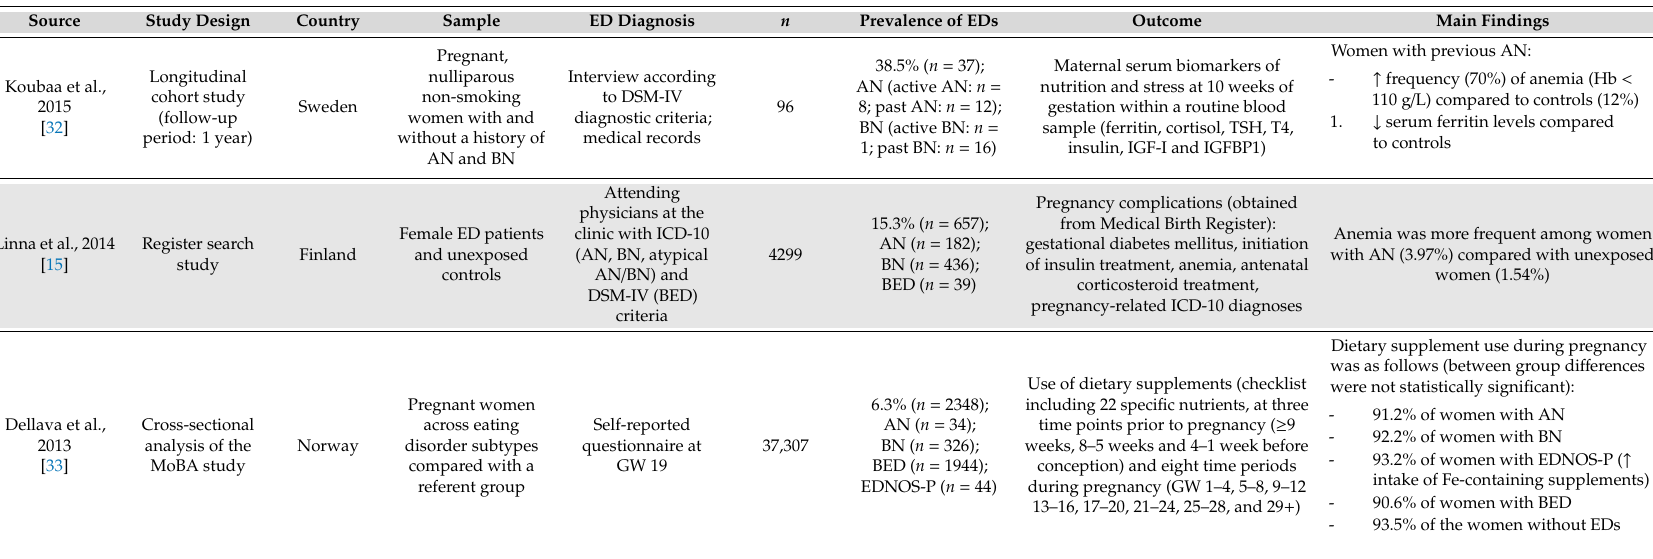
Table 2. Studies investigating nutritional biomarkers and dietary supplement use in pregnant women with eating